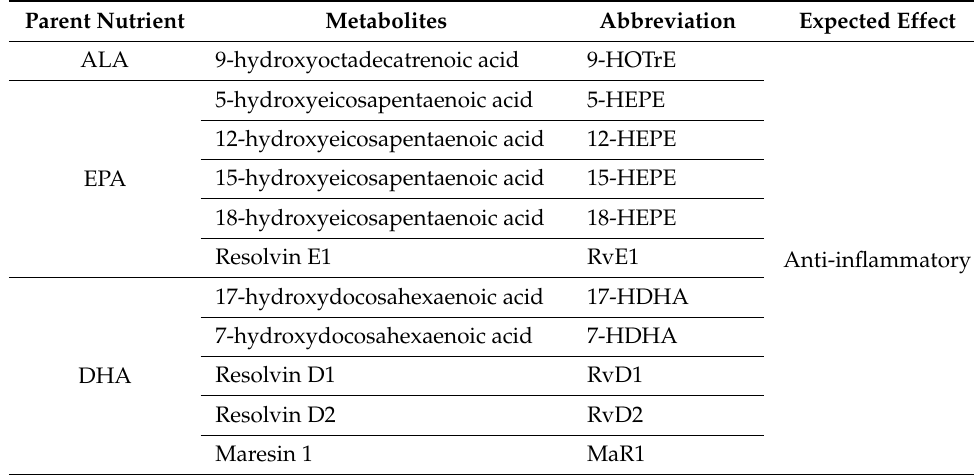
Table 12. n-3 FA metabolites and abbreviations.